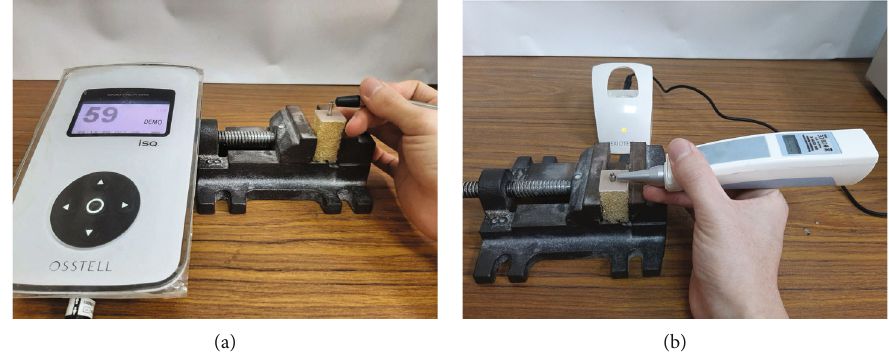
Figure 3: Measuring the initial stability of dental implant: (a) ISQ and (b) PTV. Table 1: ITV of the three insertion approaches for GB and PB. Insertion approach Statistical